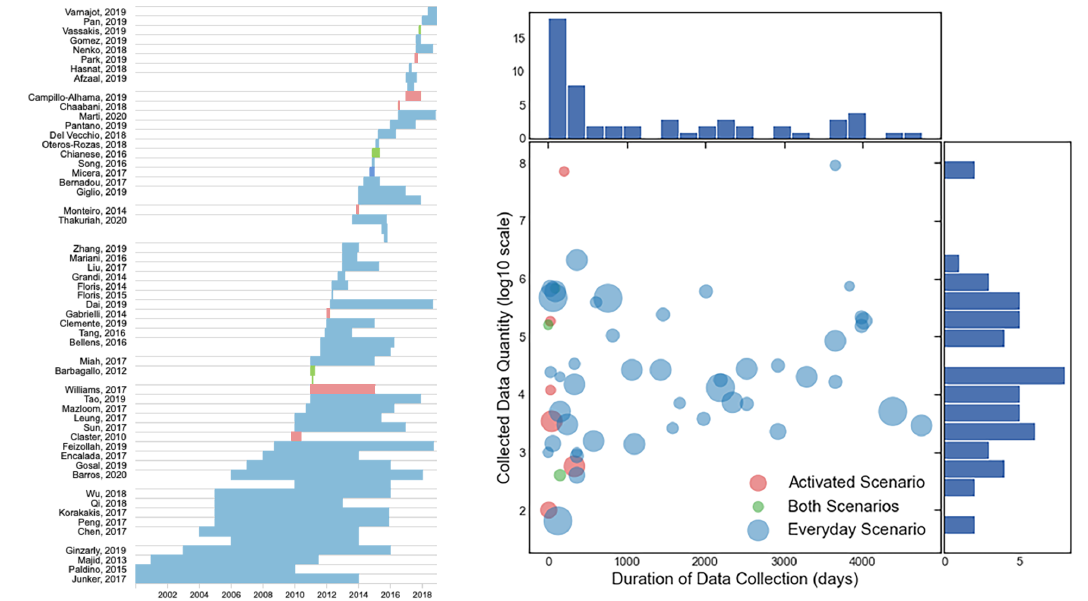
Figure 7. Left: the data collection duration (start time – end time) of the reviewed research; Right: the relationship between data collection duration and data quantity. The sizes of points show the proximity of the research to now, meaning that the later the record is published, the larger the point. The distributions of the duration and quantity are shown with histograms, in top and right, respectively. The colors in both graphs distinguish literature focused on “everyday”, “activated” or “both”